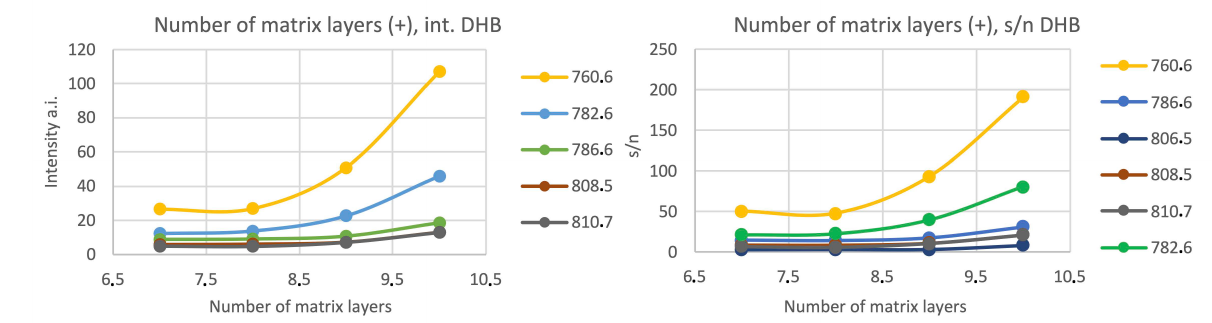
Figure 5. The relationship between the chosen peaks’ intensities and signal-to-noise ratio (s/n) in terms of the number of matrix layers for the positive ionization mode, matrix: 25 mg/mL DHB (50% MeOH, 0.2% TFA), nozzle position: Z = 25.